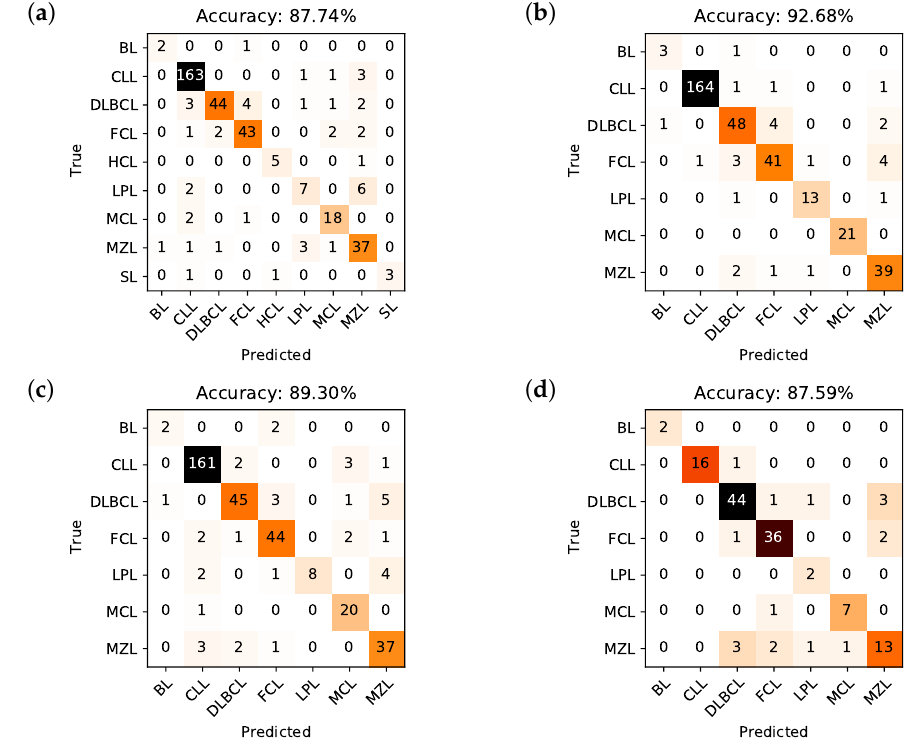
Figure 2. Confusion matrices and corresponding overall accuracies for the classifiers associated to Model I ( a ), Model II ( b ), Model III ( c ), and Model IV ( d